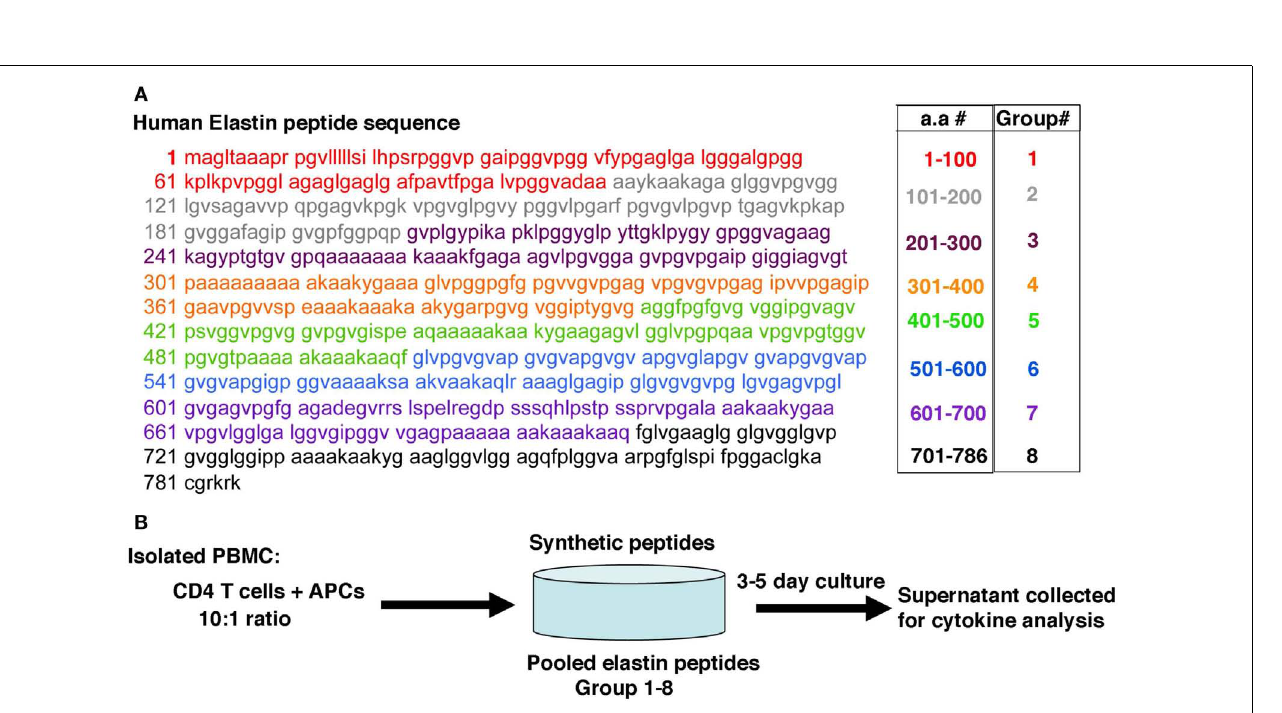
FIGUREA3 | Longitudinal study of association between IL-17, IL-10, and IL-13 in autoreactiveT cells and physiological decline. The change in 6-min walk distance (6MWD) in meters, over 2years is plotted against the fold